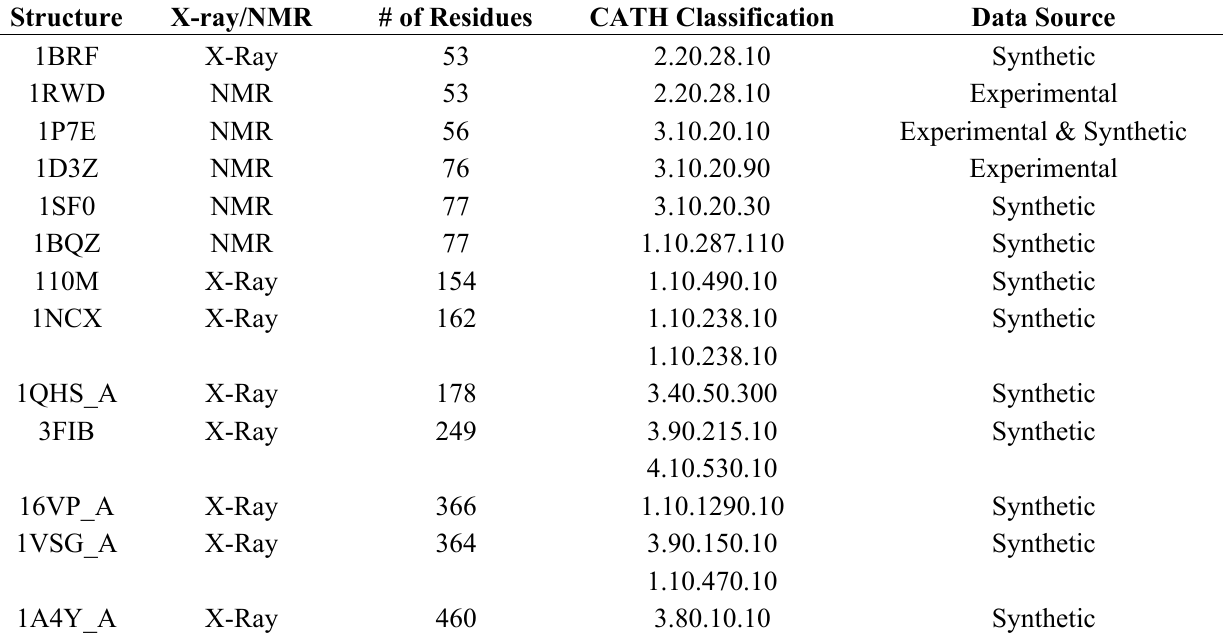
Table 9. Summary of Target Structures tested with